Question: What does this figure show? Answer in one sentence.
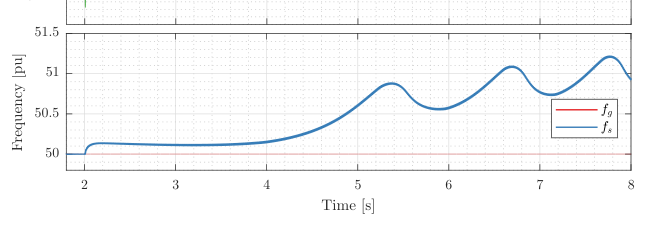
Answer: VSM Instability during current limitation — Top: ac currents in [p.u.] with Is base; Bottom: ac frequency in [Hz].